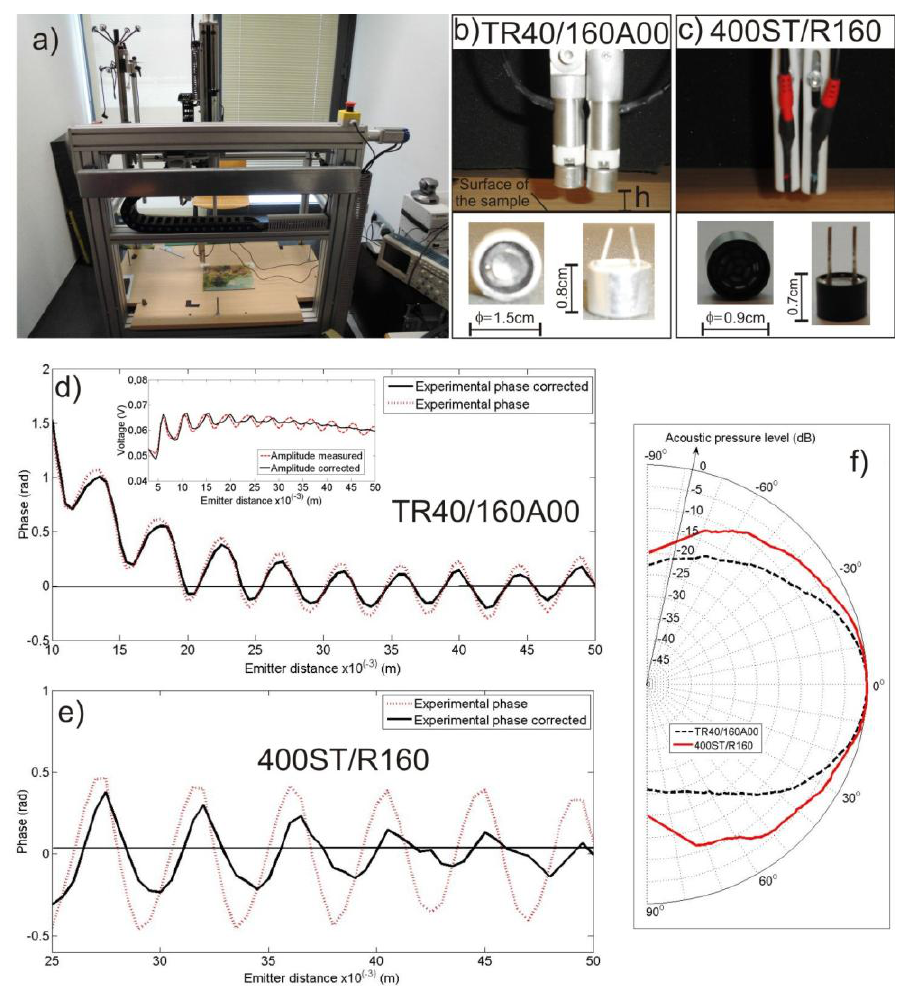
Figure 2. ( a ) Experimental setup: photograph of a general view of the 3D Robotized measurement system; ( b , c ) Arrangement of the transmitter/receiver transducers. At the bottom one can see the main geometrical characteristics of the transducers; ( d , e ) Experimental phase and the fit for both pairs of transducers as a function of the distance h . The inset in ( d ) shows the experimental phase and the fit for the corresponding transducer. ( f ) Directivity pattern measured for both